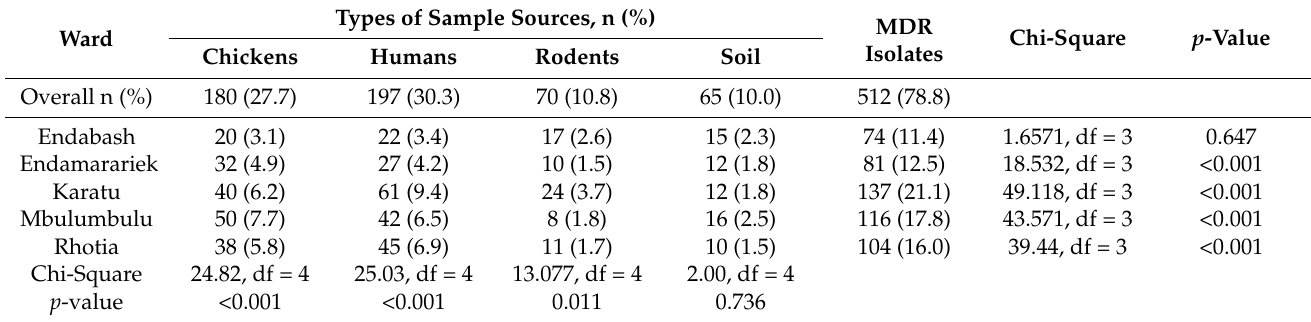
Table 3. Prevalence of MDR E. coli isolates from all types of samples in different wards in Karatu